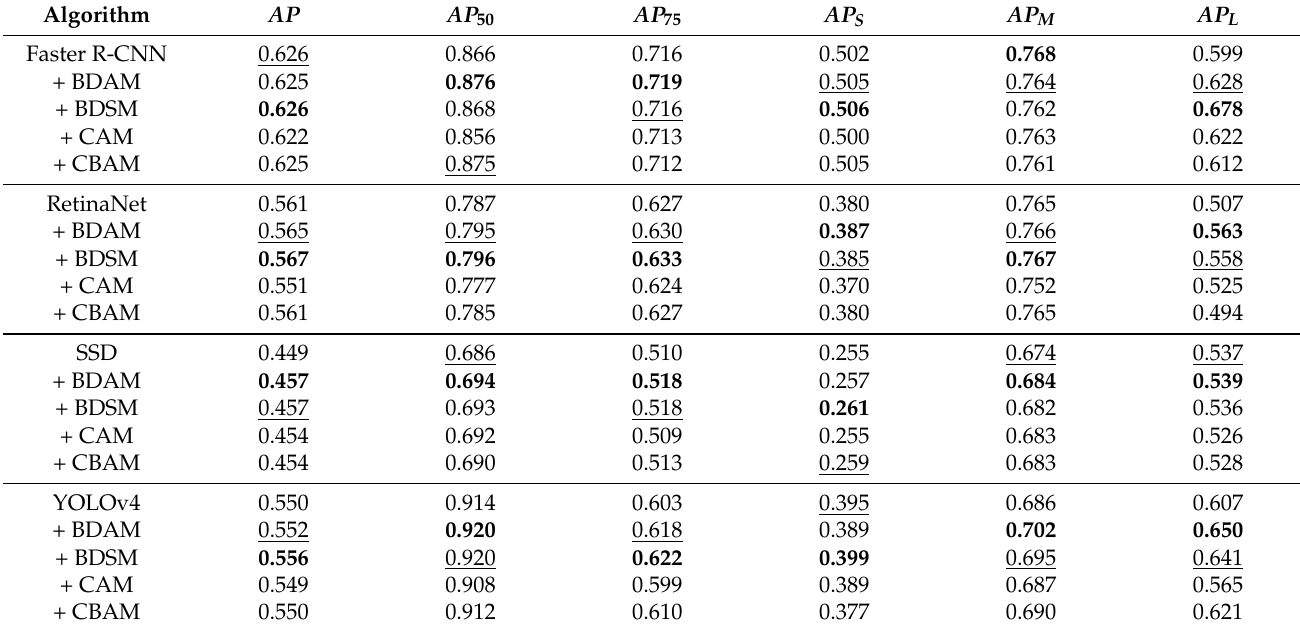
Table 11. Comparison of BDSM with different attention mechanisms. Bolded data represent the best and underlined data represent the second